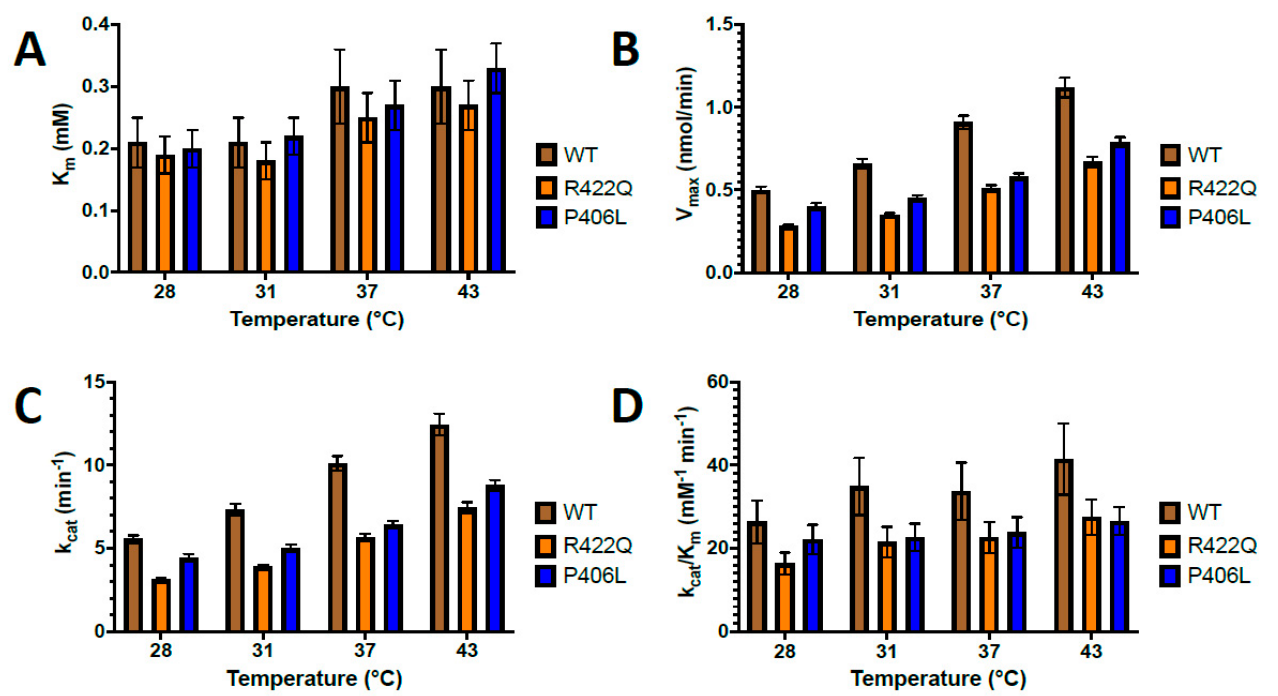
Figure 2. Kinetic parameters of WT and OCA1B-related mutants at increasing temperatures. The K m , V max , k cat , and enzyme efficiency increased with increasing temperature for both WT and mutant variants, as shown in panels ( A – D ), respectively. However, the WT exhibited higher V max , k cat , and enzyme efficiency as compared with mutant variants. WT, R422Q, and P406L are shown in brown, orange, and blue, respectively. Each data point represents the average of duplicate measurements, with error bars representing standard deviations.